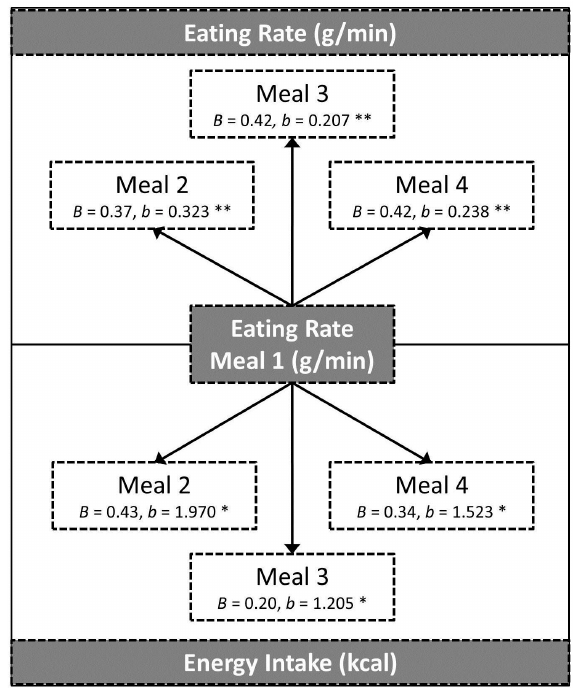
Figure 3. Standardised ( B ) and unstandardized ( b ) regression coefficients for the relationship between eating rate at Meal 1 and Eating rate and Energy intake at all the other meals, controlling for meal pleasantness and study. * p < 0.05, ** p < 0.001.